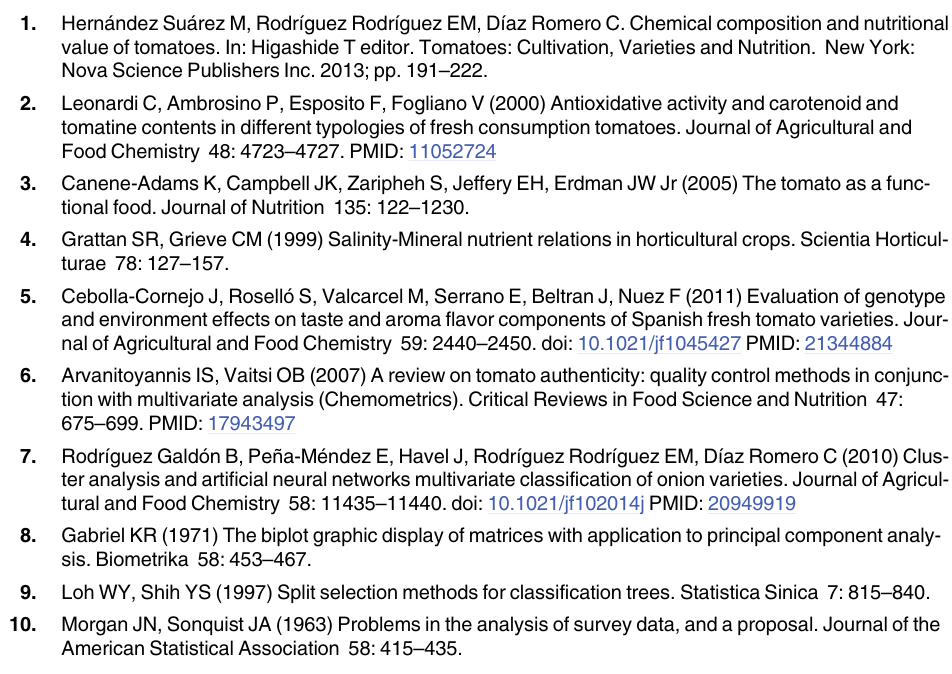
S1 Table. Mean values according to the harvest date. S2 Table. Mean values according to the agricultural practices. S3 Table. Mean values according to the tomato cultivars. S4 Table. Results of ANNs